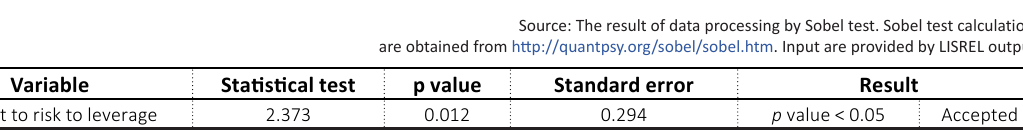
Table 4. The indirect influence of investment, risk and